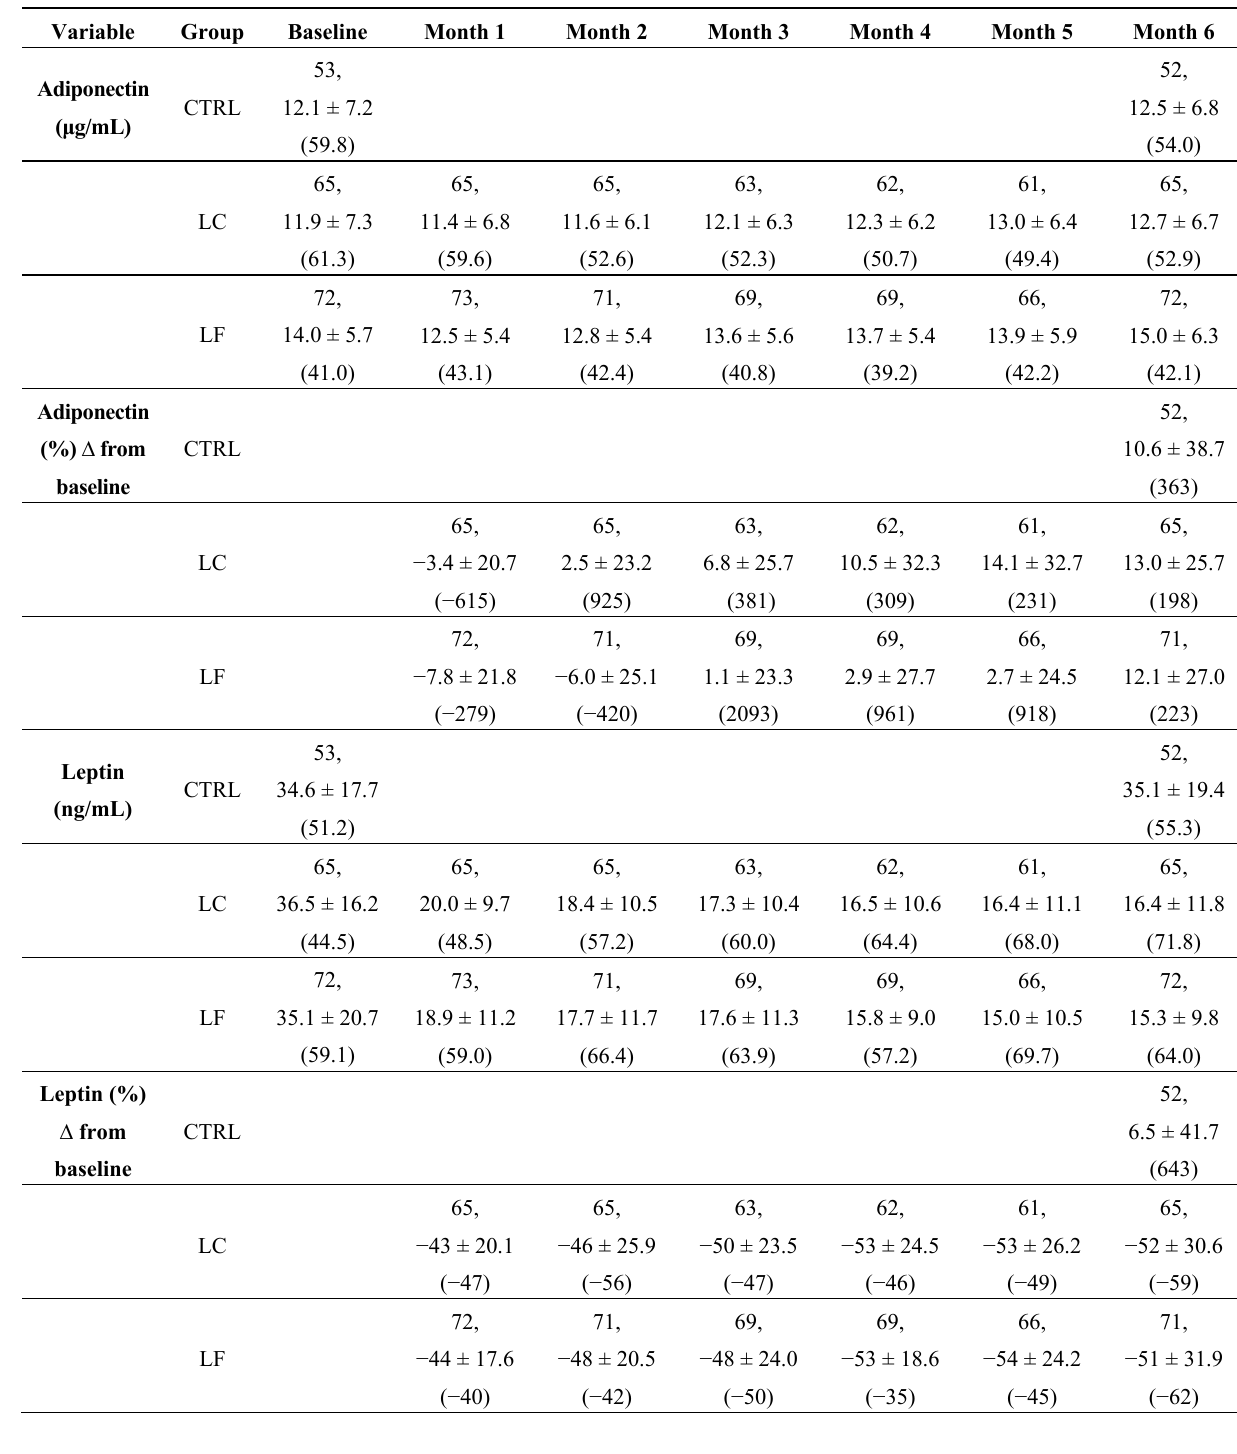
Table 2. Adiponectin and leptin with change relative to baseline 1